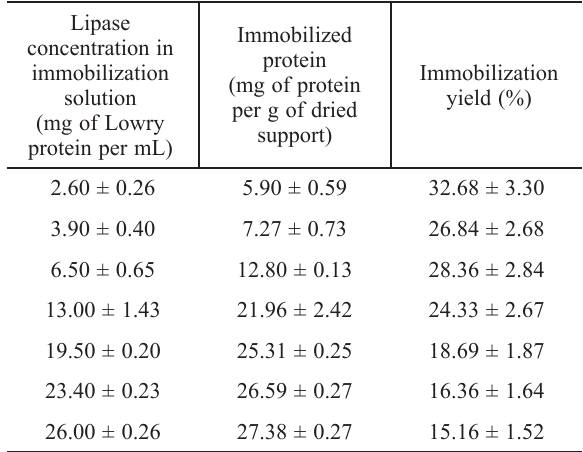
Table 1 – Experimental results obtained in the immobiliza- tion of Lipozyme ® CALB L on Lewatit ® Monoplus MP 64 to study different lipase solution